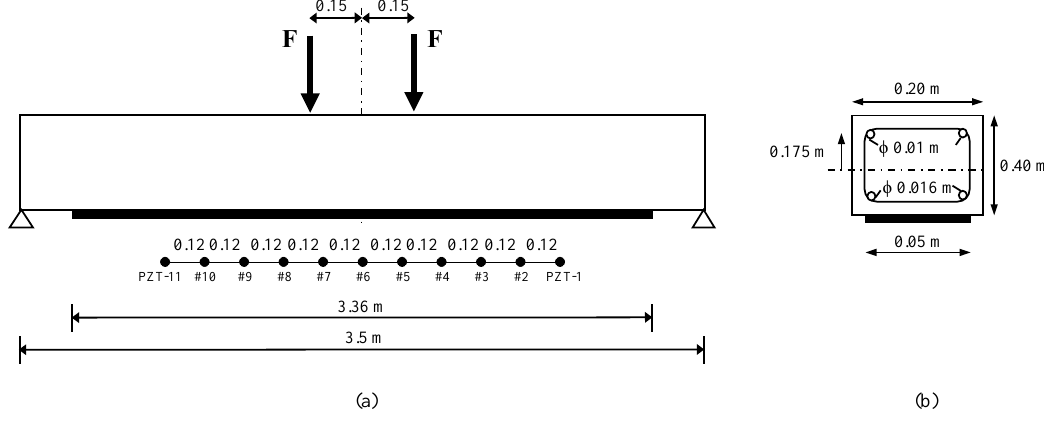
Figure 18. ( a ) Geometry, loading scheme, and sensor location map for the RC beam; ( b ) Cross-section of the beam.